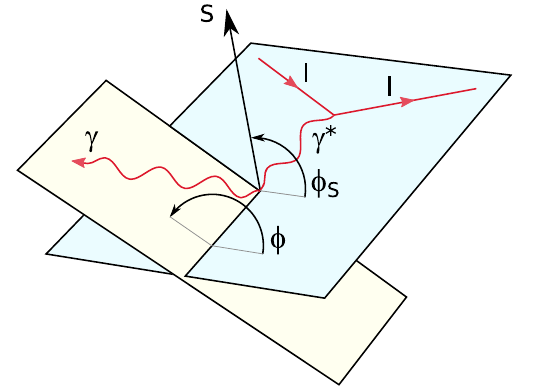
Fig. 1 Kinematics of DVCS in the target rest frame. φ is the angle between the leptonic plane (spanned by the incoming and outgoing lep- ton momenta), and the production plane (spanned by the outgoing pho- ton and nucleon momenta). φ S denotes the angle between the nucleon polarization vector and the leptonic plane